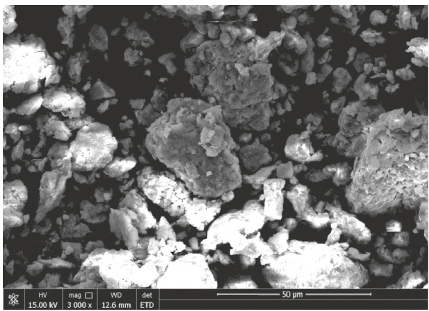
Figure 2: Microstructure of the expansive soil